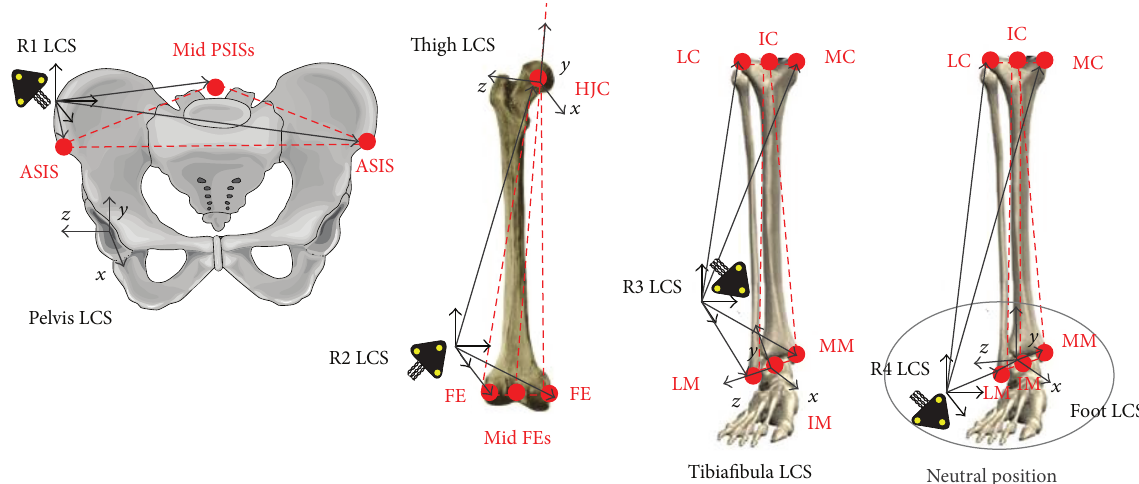
Figure 2: Joint Coordinate System definition according to ISB recommendation [5] based on anatomical landmarks measured with respect to the appropriate cluster of